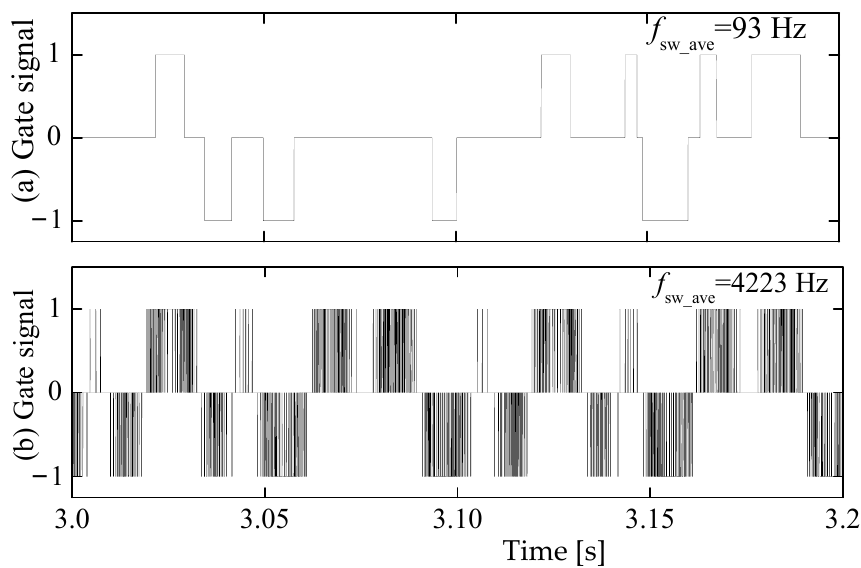
Figure 11. Gate signals of one SM in arm Aa with di ff erent SM voltage balancing methods: ( a ) reduced switching frequency method; ( b ) conventional method.